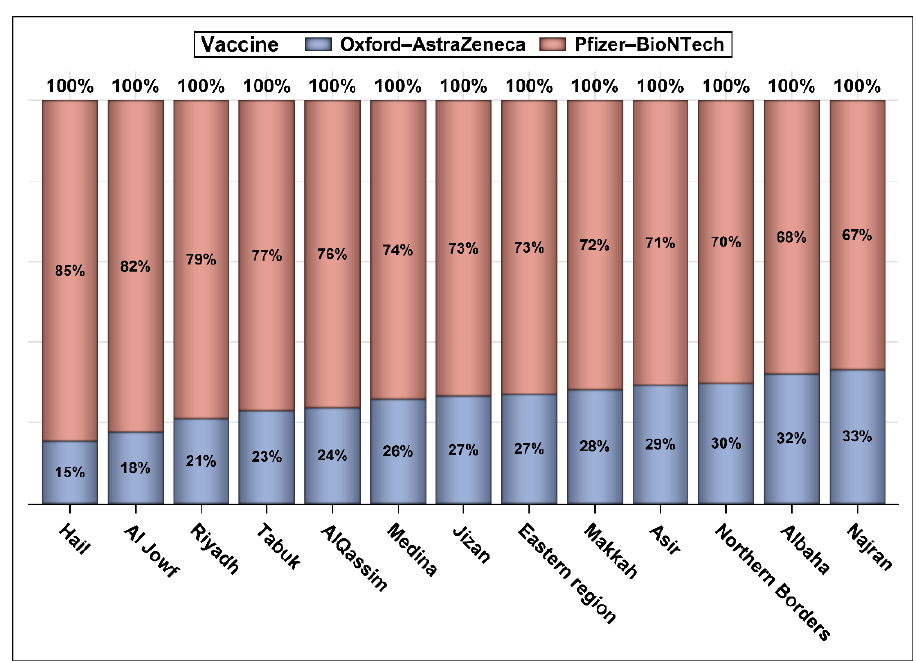
Figure 2. Number of persons vaccinated in each region.